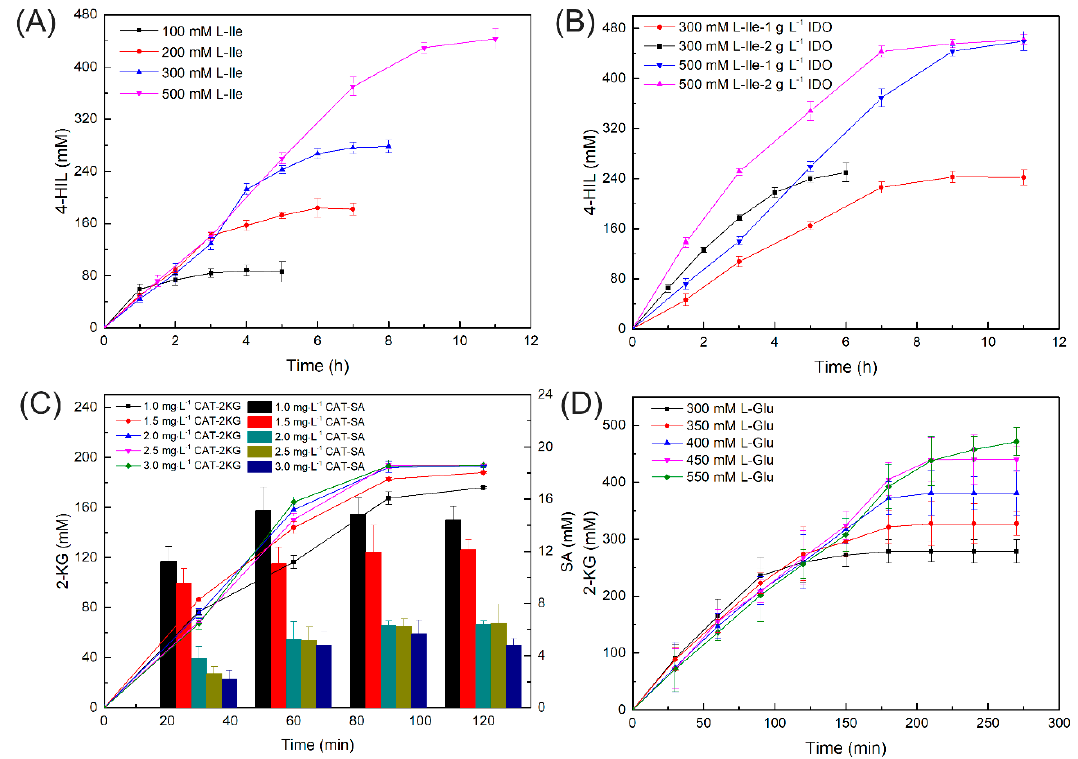
Figure 5. Optimization of biocatalyst and substrate concentrations. ( A ) 4-HIL production at different L-Ile concentrations with 1 g · L − 1 IDO; ( B ) 4-HIL production at various IDO concentrations; ( C ) 2-KG L-Ile concentrations with 1 g·L -1 IDO; ( B ) 4-HIL production at various IDO concentrations; ( C ) 2-KG and SA yield at di ff erent CAT concentrations in presence of 0.5 g · L − 1 LGOX; ( D ) 2-KG yield at various and SA yield at different CAT concentrations in presence of 0.5 g·L -1 LGOX; ( D ) 2-KG yield at various L-Glu concentrations in presence of 0.5 g · L − 1 L-Glu concentrations in presence of 0.5 g·L -1 LGOX.